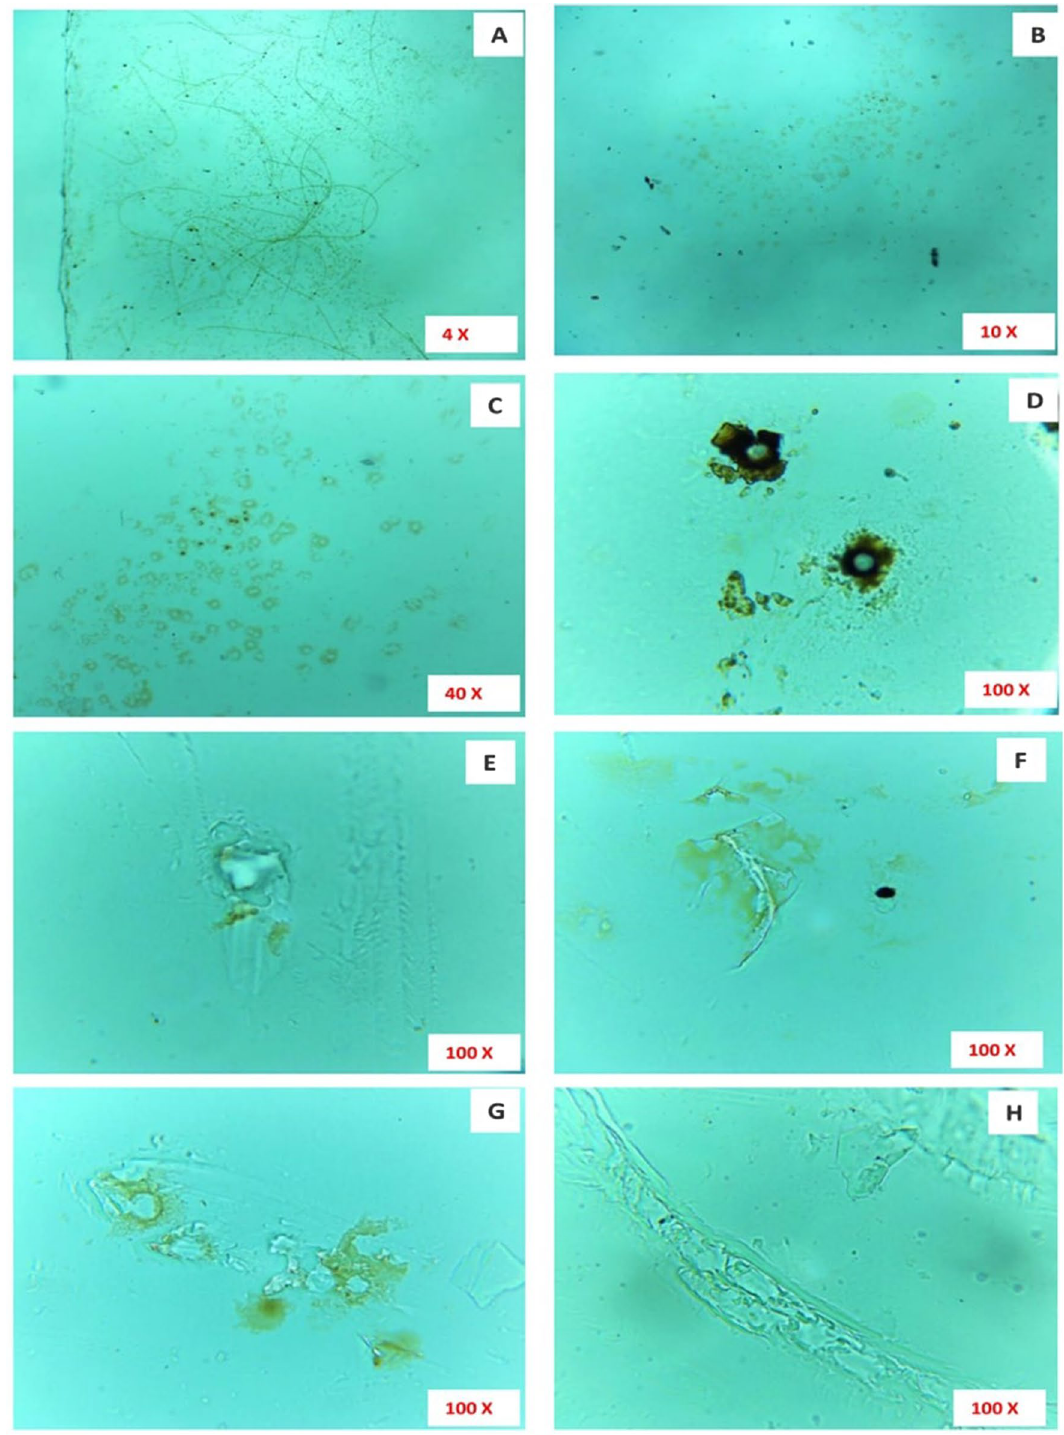
Figure 10. Microscopically magnified, washed LDPE sheet. ( A ) The × 4 magnification of washed LDPE sheet showing hair-like structures still present on the LDPE sheet; ( B , C ) × 10 magnification of the radial disc, still present after washing; ( D ) A × 100 magnification of radial disc after washing, with absence of microalgal filament; ( E – H ) × 100 microscopical images clearly indicate erosions, abrasions and grooves and ridges on the surface of the LDPE